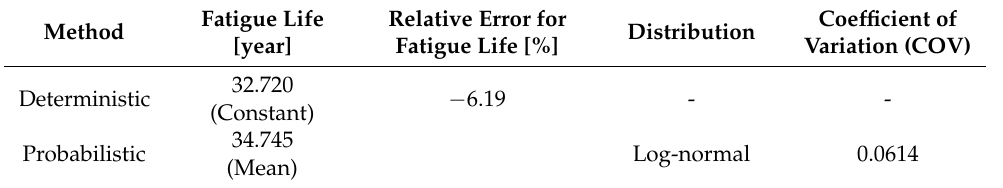
Table 6. Fatigue life comparison.